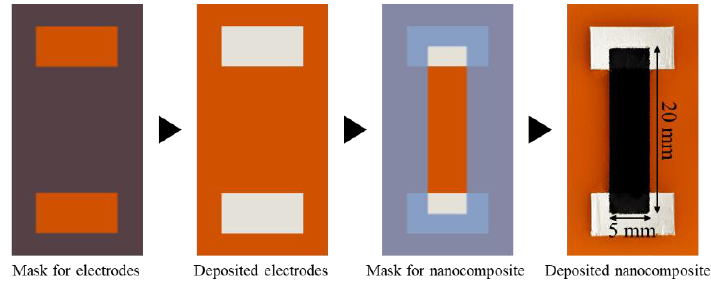
Figure 1. Graphical representation of the nanocomposite thin film fabrication process.